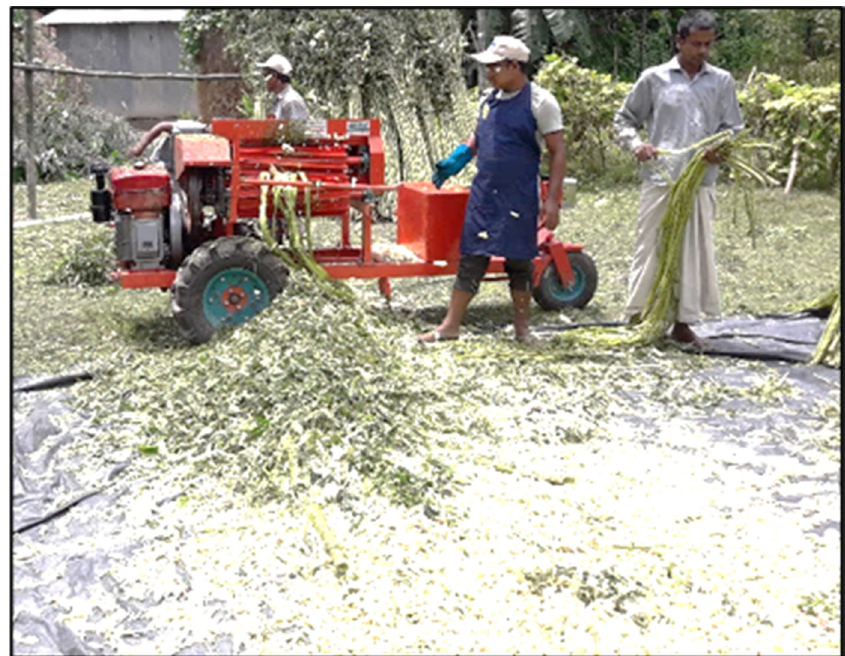
Figure 11. Jute fiber extraction by the developed Aashkol .